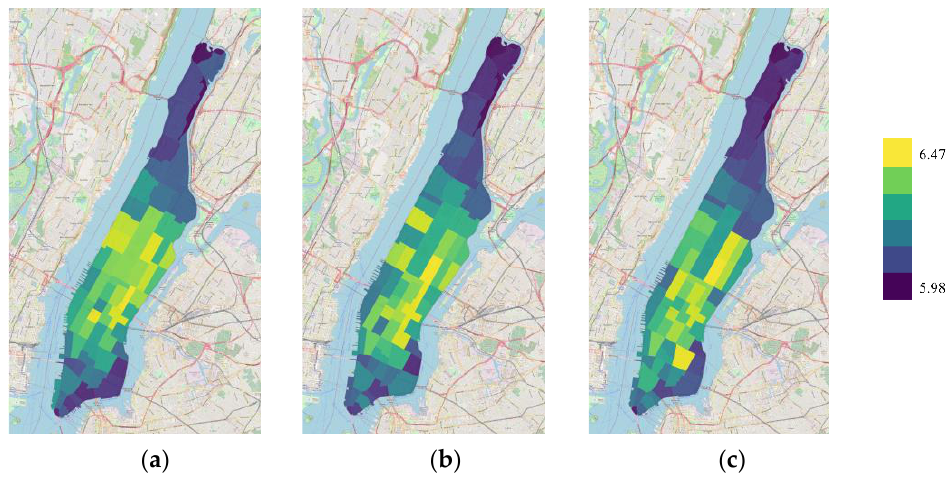
Figure 5. Heat maps of spatial distribution of HDGCN’s RMSE at different time periods: ( a ) 9:00; ( b ) 18:00; ( c ) 22:00.